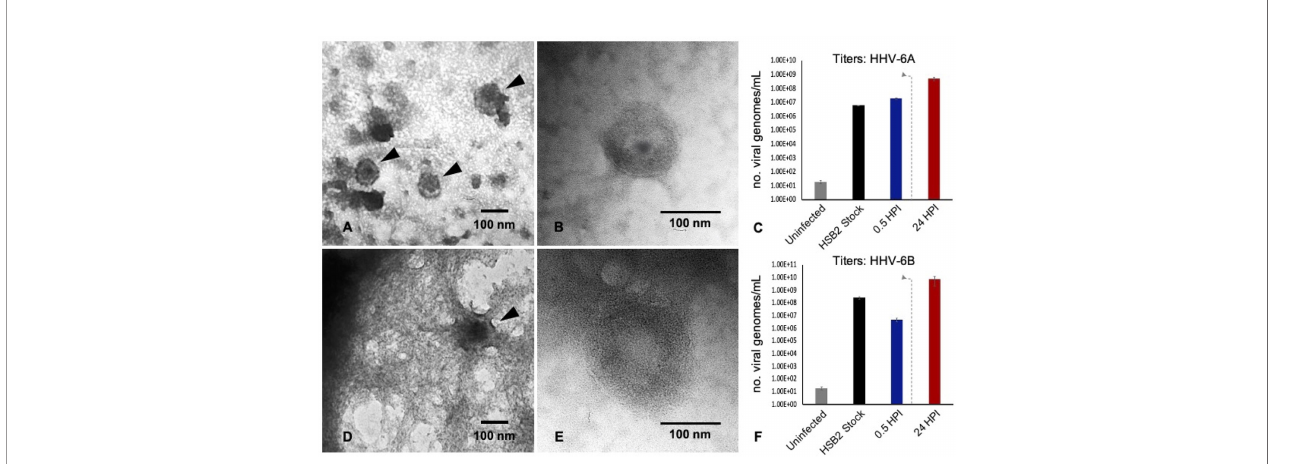
FIGURE 3 | TEM and qPCR data from HHV6-infected dHNSC. TEM images illustrate: (A) HHV-6A virus particles within a cell; (B) HHV-6A virions in cell-free fi ltered supernatant from cell lysate; (D) HHV-6B virions in a cell; (E) HHV-6B virions in cell-free fi ltered supernatant. qPCR titer methods show productive virus infection for: (C) HHV-6A and (F) HHV-6B. Uninfected cells show negligible ampli fi cation of an HHV6-speci fi c marker (i.e., U22 gene). After 30 min post-infection HHV6 is still present. After a wash at 2 HPI (dashed line) and 22 h incubation (24HPI), titers increase indicating production of progeny virions at densities greater than the number